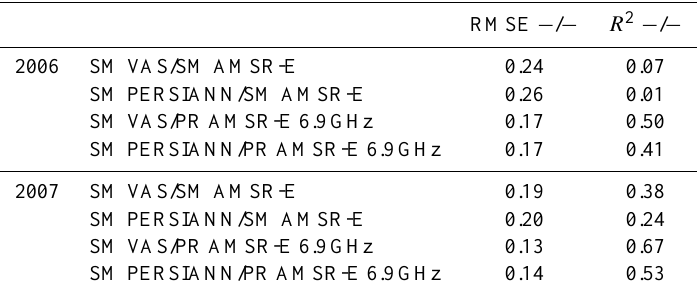
Table 5. Statistical analysis between SM VAS (spatialized soil moisture obtained using in situ observations), SM PERSIANN (spatialized soil moisture data obtained using PERSIANN satellite rainfall estimates), SM AMSR-E (AMSR-E soil moisture product) and PR AMSR-E (AMSR-E polarization ratio 6.9GHz) for 2006 and